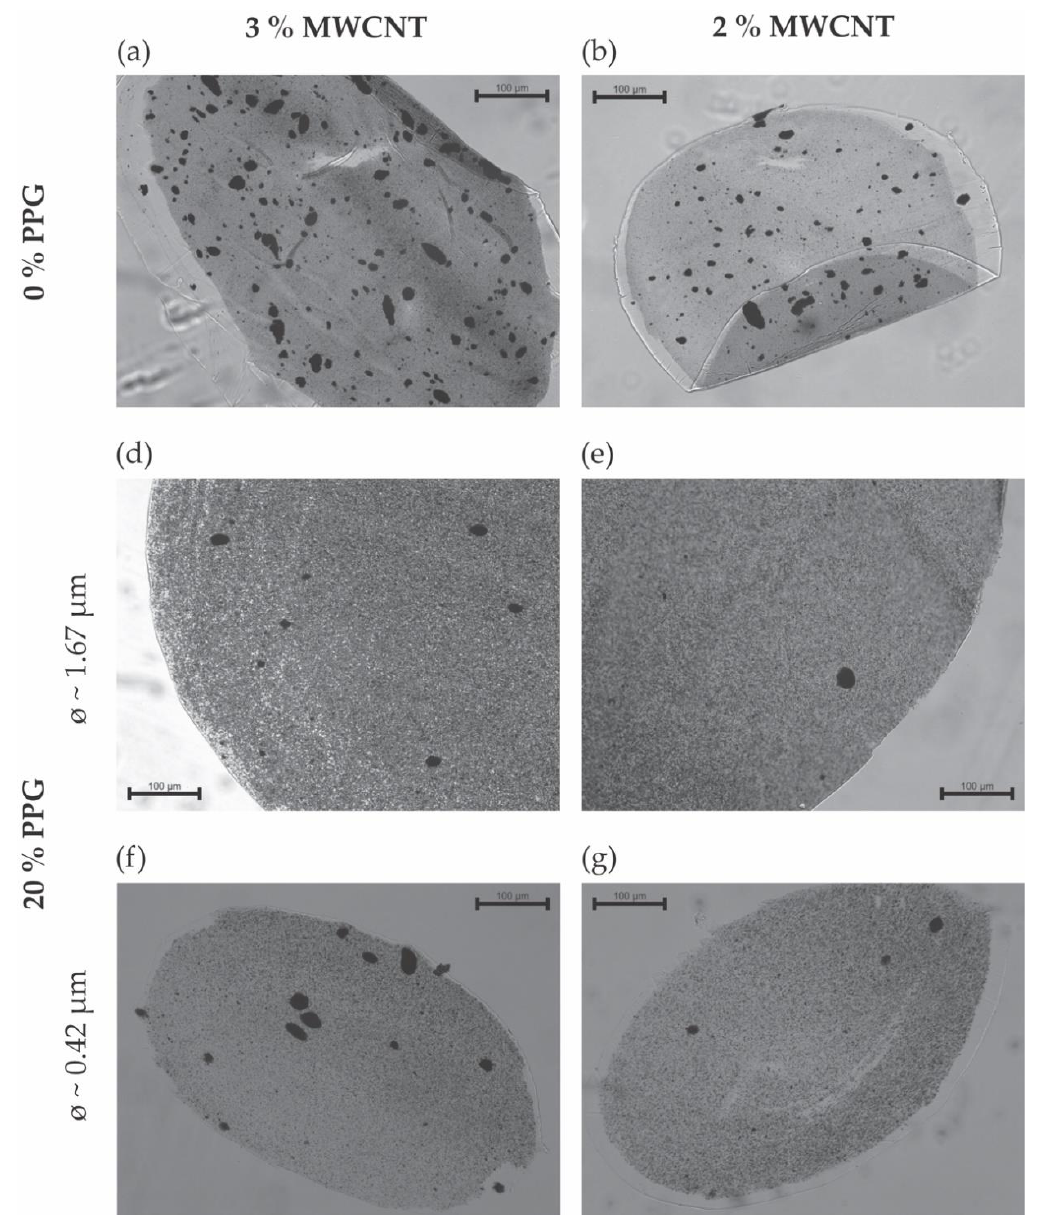
Figure 2. Optical microscopy (OM) (transmission mode) images of filament composites with different diameters, filler load, and PPG wt.%. Table 3. Quartiles (Median, Q 1 , and Q 3 ) of the areas measured per sample, area ratio, and count of agglomerates per mm 2 .